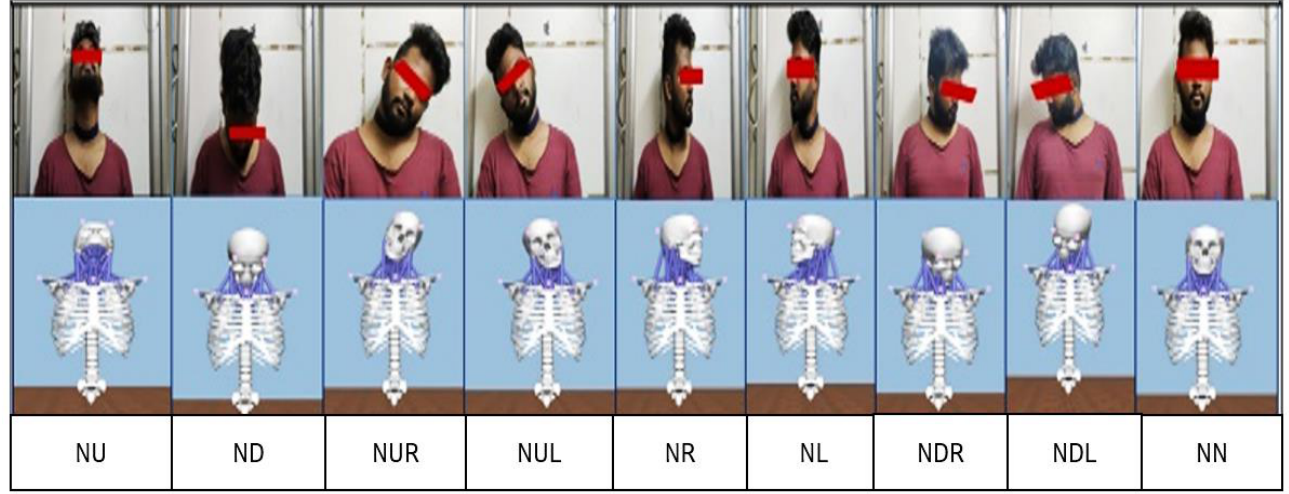
Figure 7. Subject-specific neck postures with corresponding musculoskeletal postures in OpenSim.